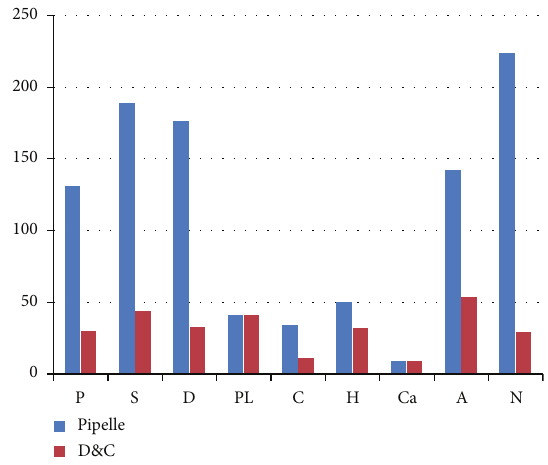
Figure2:Adiagramshowingthedistributionofdifferentdiagnostic categories between the two diagnostic methods (P: proliferative endometrium, S: secretory endometrium, D: disordered prolifera- tive endometrium, PL: endometrial polyp, C: chronic endometri- tis, H: endometrial hyperplasia, Ca: endometrial carcinoma, A: trial polyp and chronic endometritis, an endometrial polyp in a background of secretory or proliferative endometrium or atrophic endometrium, and N: